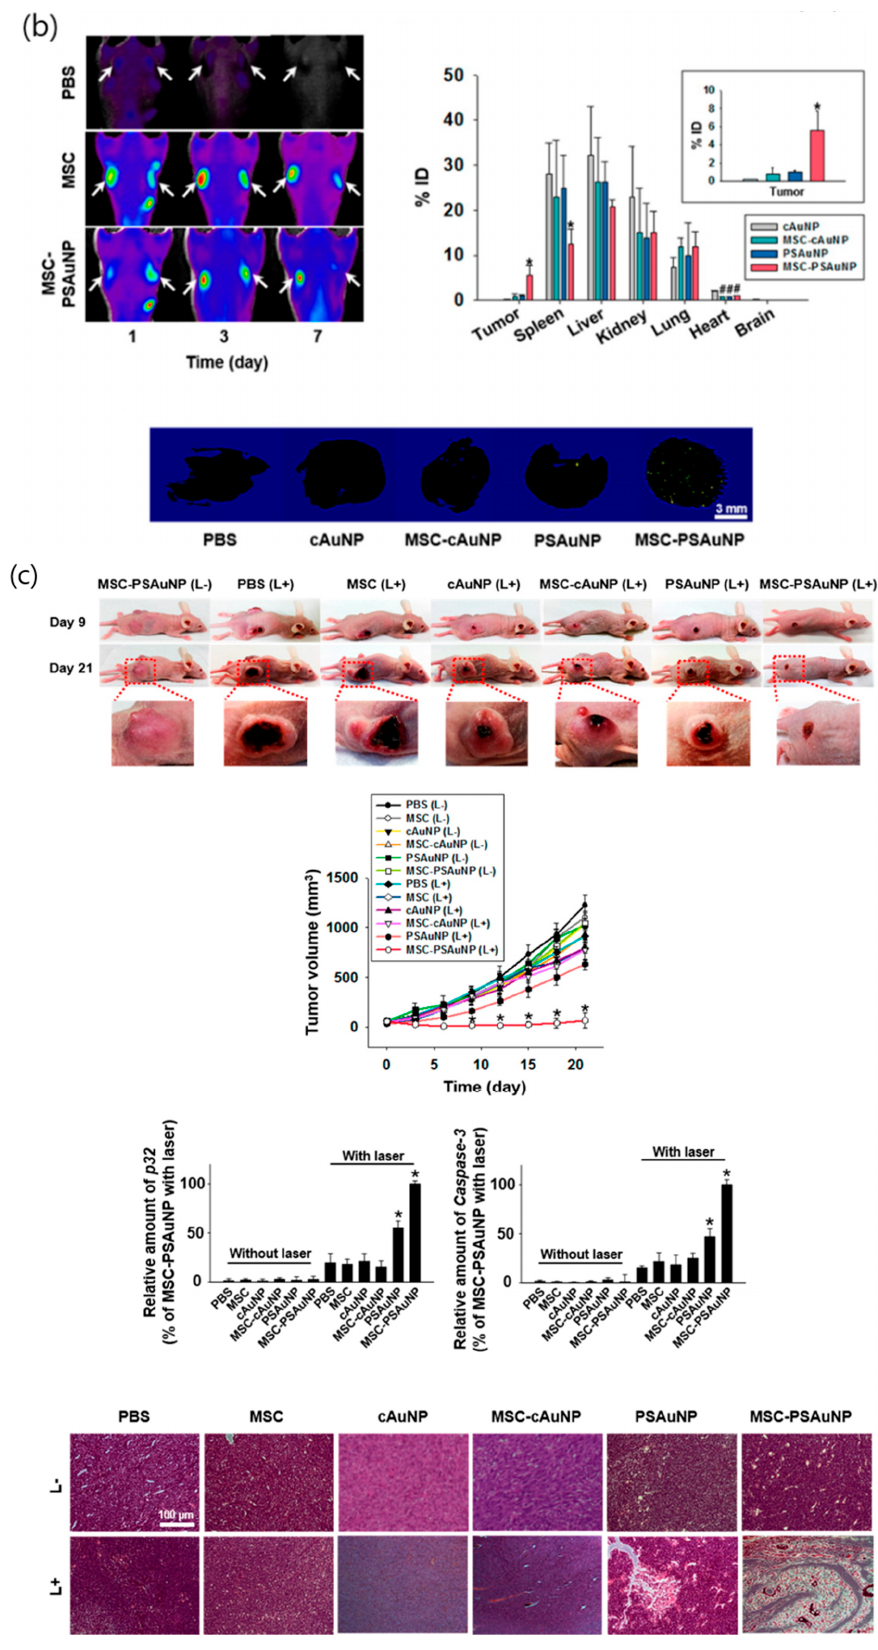
Figure 2. ( a ) Temperature measurements during laser irradiation to demonstrate photothermal effects of a single treatment and three consecutive treatments of mesenchymal stem cells (MSCs) with PSAuNPs, * p < 0.05 versus any group, # p < 0.05 versus MSC-cAuNP 90 µg/mL group; ( b ) In vivo tumor targeting and biodistributions of the AuNPs, * p < 0.05 versus any other group. # p < 0.05 versus the cAuNP group; ( c ) Volume profiles of each tumor tissue; apoptotic activity in the tumor tissues after laser irradiation and hematoxylin and eosin staining images of thin sections of the tumor tissues with or without irradiation, * p < 0.05 versus any other group. Reproduced from [89], copyright permission by ACS Publication 2015.